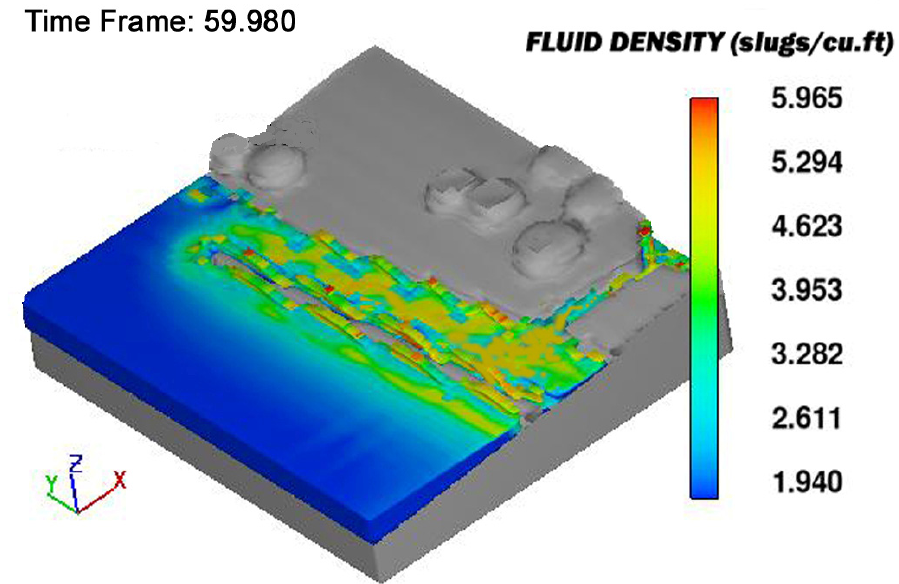
Figure 24. CFD calculated sediment deposition history of a later El Niño flood event interacting with the sediment deposit from an earlier flood deposit event (offshore grey bar ridge area). Note the formation of a water-laden backfilled marsh area between the shoreline and the beach ridge. Figure 24 shows what happens when a later flood event occurs after an earlier beach ridge deposit. Trace sediment deposits occur seaward and inward from the earlier main ridge; this trace ridge alters the river outlet shape and influences river discharge patterns (Figures 22, 24 and 25), as well as altering the local seabed slope from the settled sediment, all of which alter conditions under which subsequent ridges form. In Figure 24, a trace subsea ridge (yellow-brown) was formed close to the shoreline behind a (grey) ridge formed from a prior flood event. The inner sediment deposit is the source of bay infilling and marsh creation from rainfall, river deposits and later flood events. The outer sediment deposit is the source of coastline shape alteration from sediment deposits. A sequence of distinct ridges form from later flood events that gradually accrete sediment between them to both form a ridge sequence typical of that observed in the Santa–Viru area together with alteration of the coastline shape. Based on the observations of the Santa–Viru ridge sequence formed from datable multiple flood events, computer predictions provide the underlying fluid mechanics mechanism to explain ridge formation and their observed ori- entation, shape, width and composite nature. From Figure 24, previous flood deposition events affect and influence both the inland and offshore deposition history of later flood events that contribute to shoreline growth and shape change as well as river mouth shape. This effect is manifest in Figures 17 and 18 which show inland beach ridges buried by sand aeolian sand deposits and many flood erosion events millennia after their creation. Figure 25 represents a case in which the seabed slope in the Supe Valley area from the Huara to Forteleza Valleys is steeper than that for the Santa–Viru calculations shown in Figure 22. Figure 26 how a flood deposition event alters the coastline shape deposition event—this is the fluid mechanics version that underlies coastal shape changes shown in Figure 8.The results indicate ridge deposition closer to the coastline, owing to the higher hydrostatic pressure close to the shoreline encountered by low-mass, low-inertia sediment